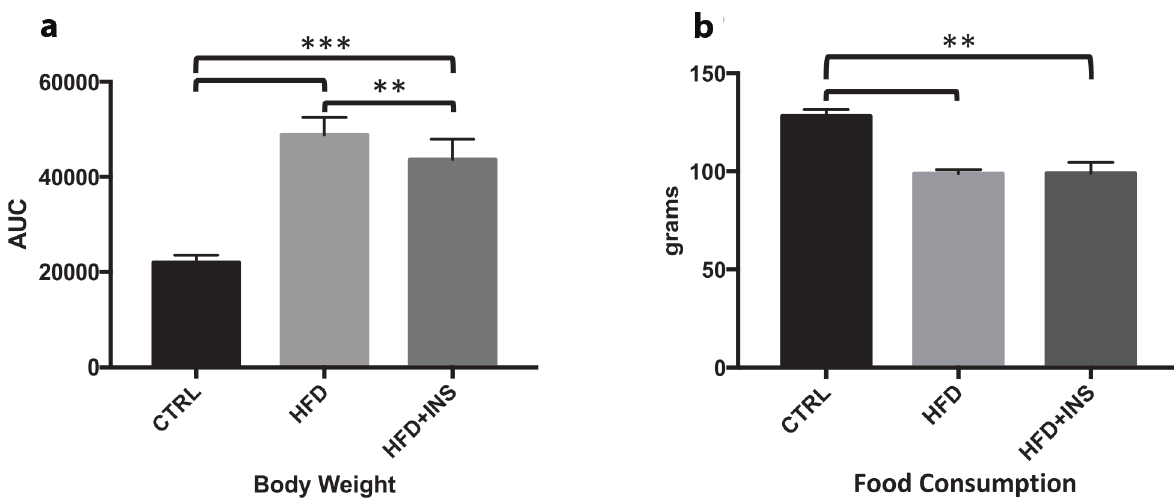
Figure 1 - ( a ) - Body weight changes in CTRL animal (standard chow) (n = 10) and in HFD (rich in fat e low carbohydrate chow) (n=10) and HFD+INS (plus oral insulin gavage) (n=10). Area Under Curve (AUC). * p<0,05 HFD versus HFD+INS, p<0,01 CTRL versus HFD and CTRL versus HFD+INS. ( b ) - Food Consumption (grams/week). ** p<0,01 CTRL versus HFD and